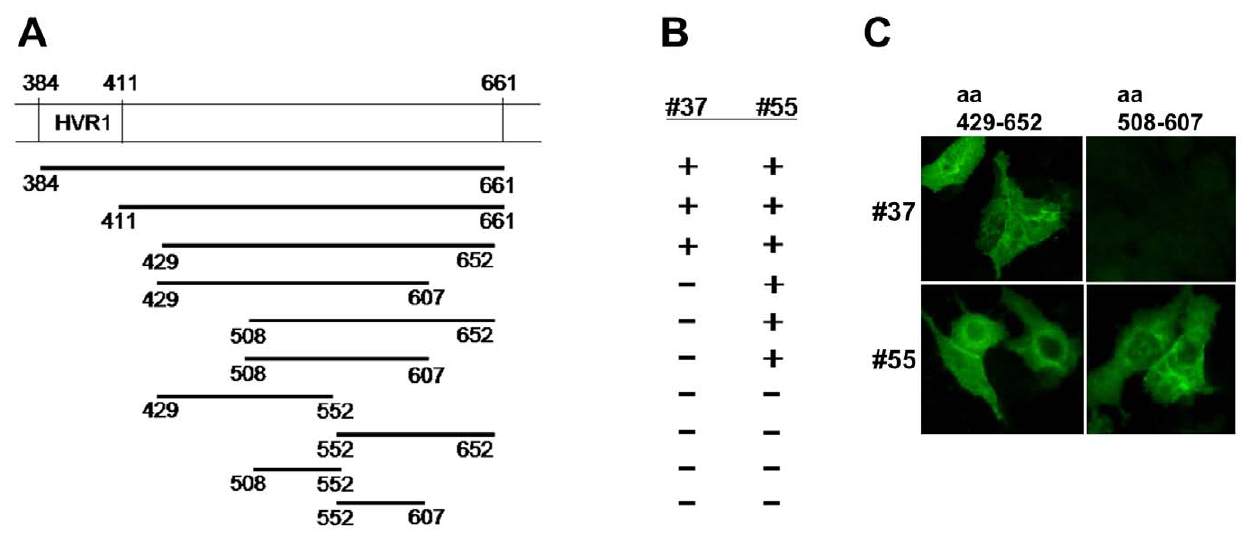
Figure 3. Epitope mapping revealed that # 37 and # 55 recognized the regions aa 429 to 652 and aa 508 to 607 of the E2 protein, respectively. ( A ). A panel of Huh7 cells expressing various truncations of the E2 protein derived from HCV strain H77 was generated. At the top of the graphic, aa 384 to 661 of the E2 protein is depicted with aa numbers. HVR1, hyper variable region 1. ( B ). Results of the assays for reactivity by IF. + , positive recognition; -, negative recognition. ( C ). IF-reactions of # 37 and # 55 against the cells expressing aa 429–652 and aa 508–607.